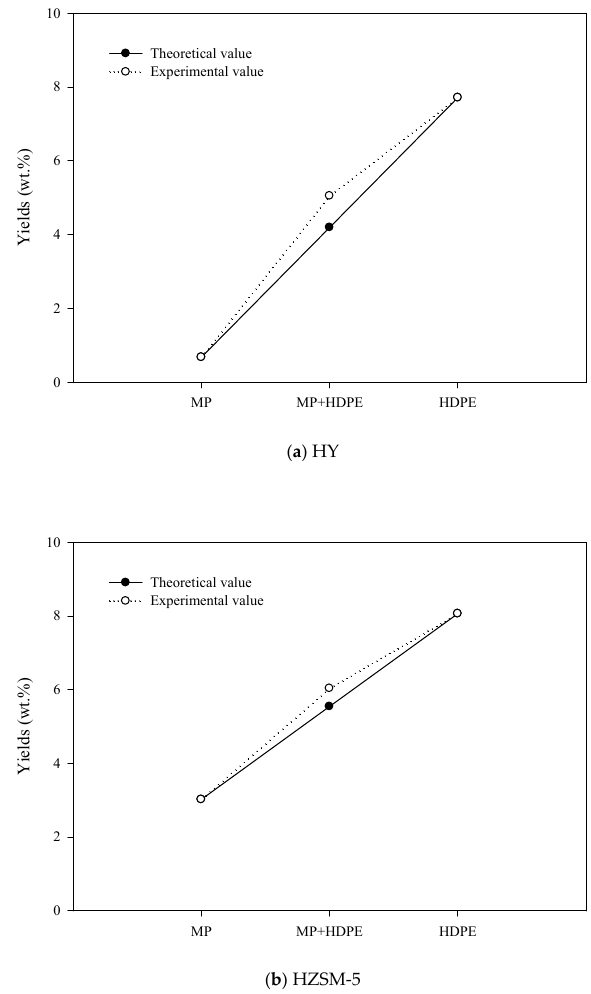
Figure 7. Theoretical and experimental yields (wt.%) of aromatics obtained from the CCFP of MP and HDPE over HY and HZSM-5. HDPE over HY and